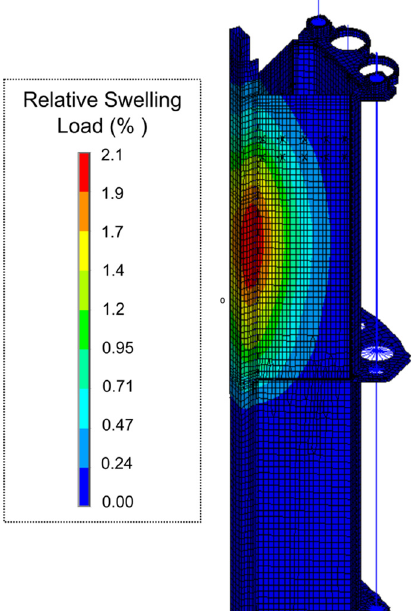
Fig. 12. Relative swelling load in P5 triangular sector ( fl uence effect).